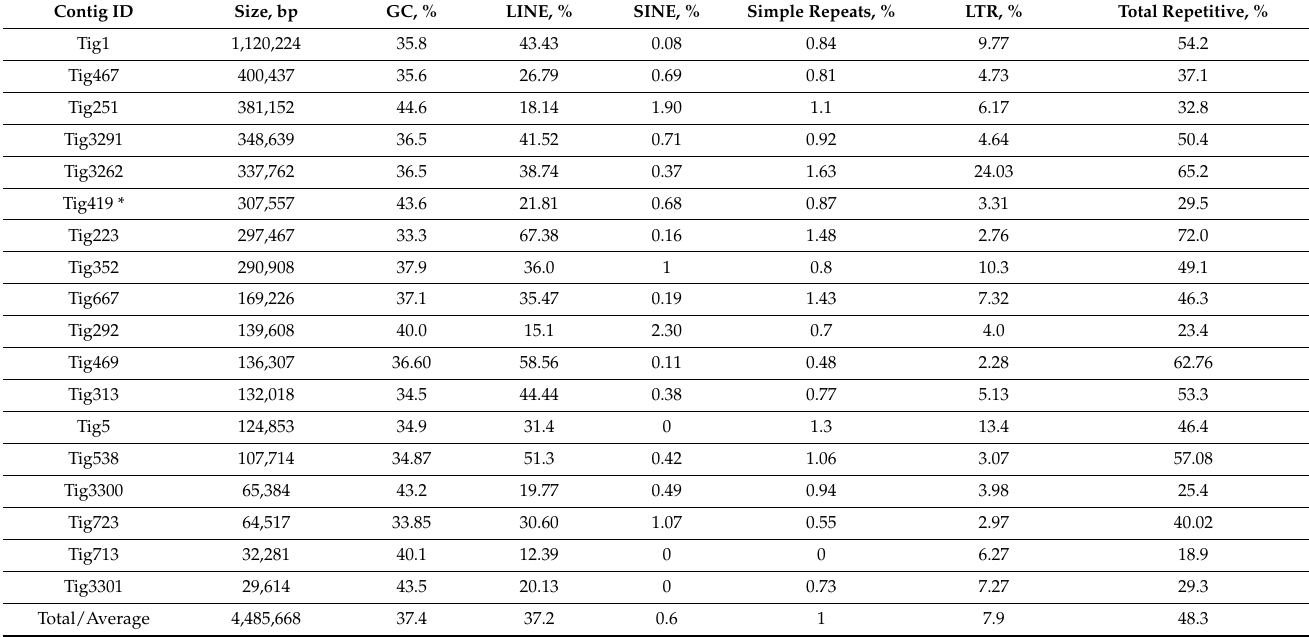
Table 2. Sequence features of alpaca MSY contigs (ordered by size); * PAB-Y: contains MSY and PAR.